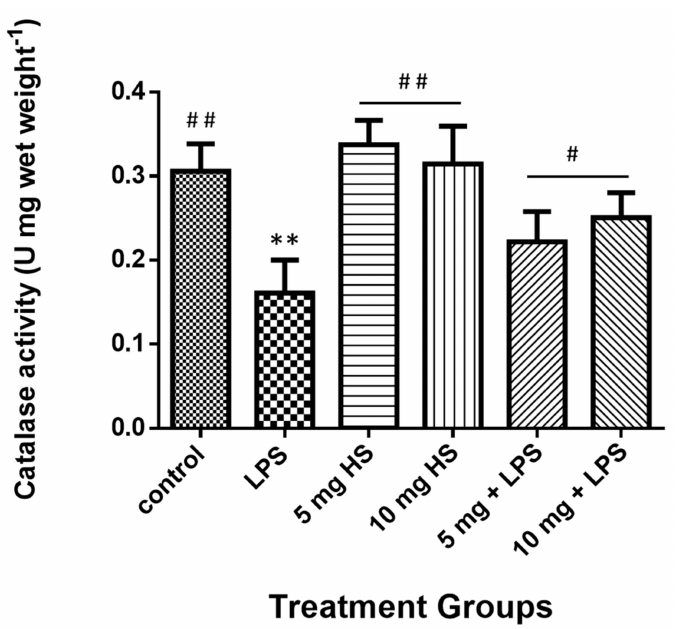
Figure 5. Treatment e ff ects on the catalase activity in mice liver homogenate. Data represents the means ± standard error (SE), n = 10. ** Significantly di ff erent from control group at ( p ≤ 0.01); # Significantly di ff erent from LPS group at ( p ≤ 0.05), ## at ( p ≤ 0.01).